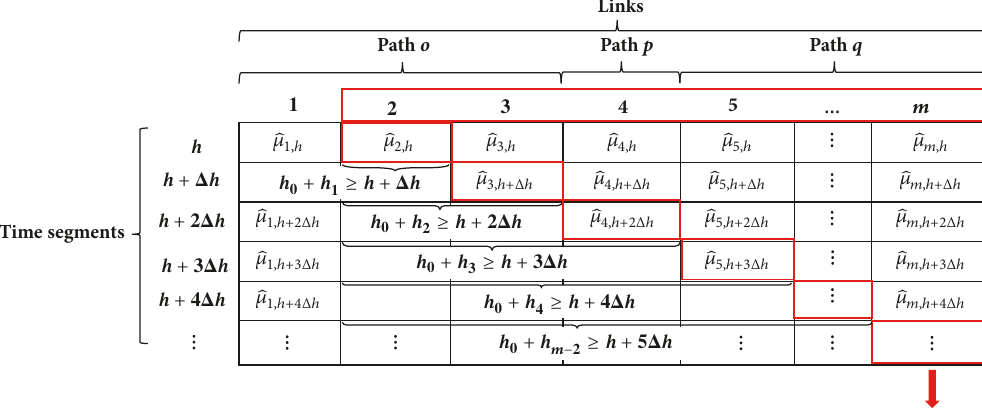
Figure 3: Path travel time of expected-empty